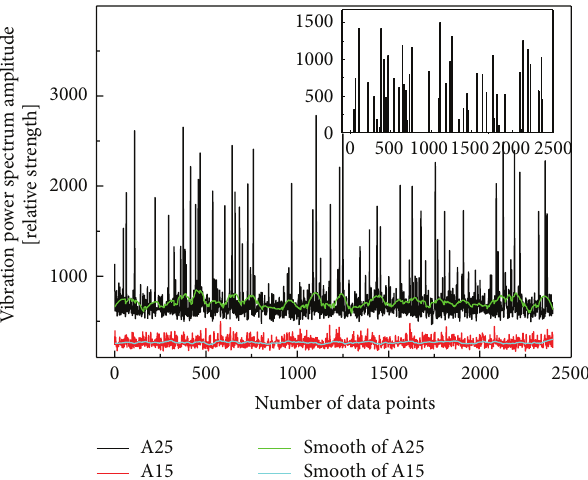
Figure 4: Comparisons of the power spectrum of number A25 well and number A15